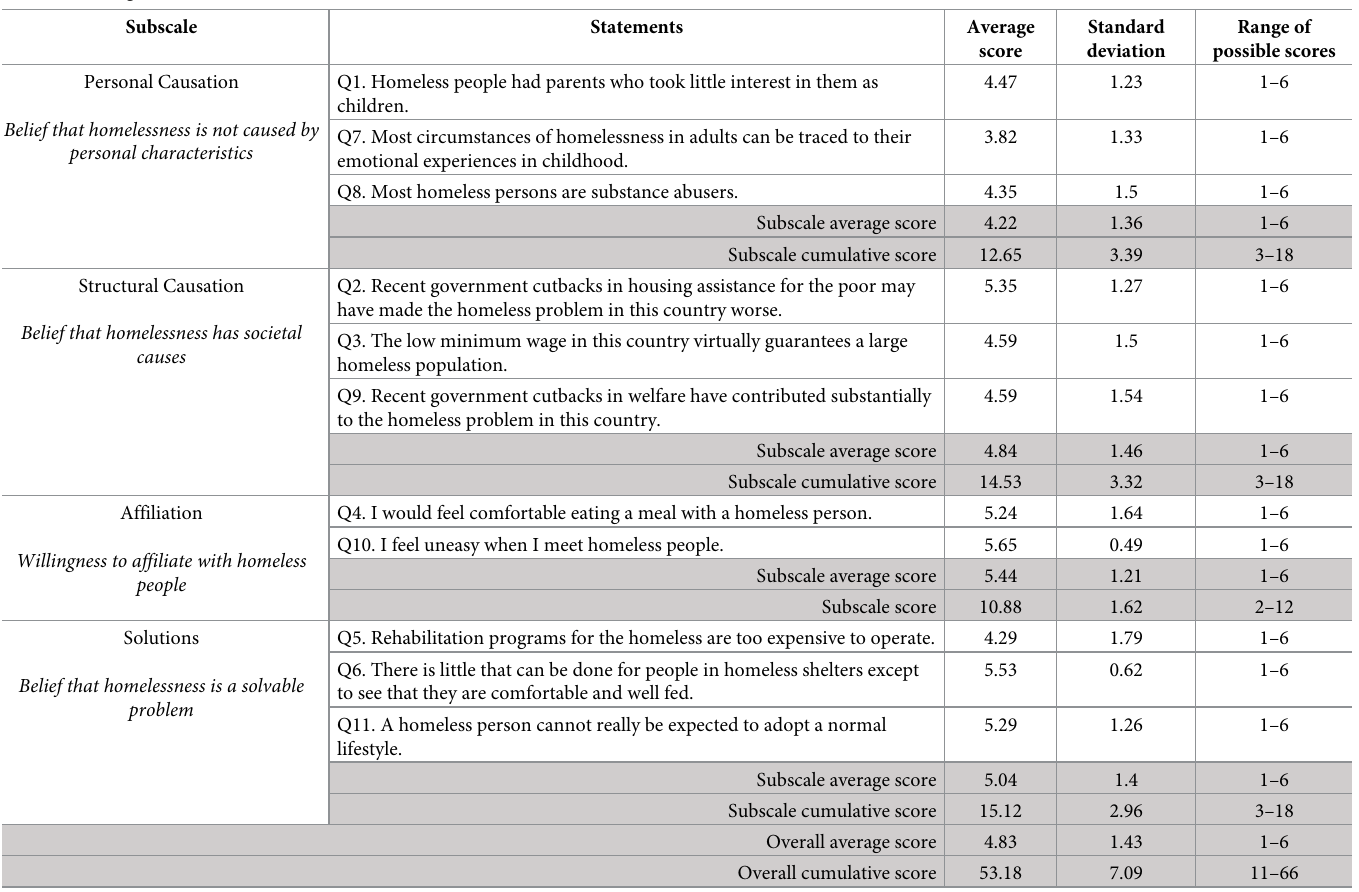
Table 2. Average and cumulative ATHI